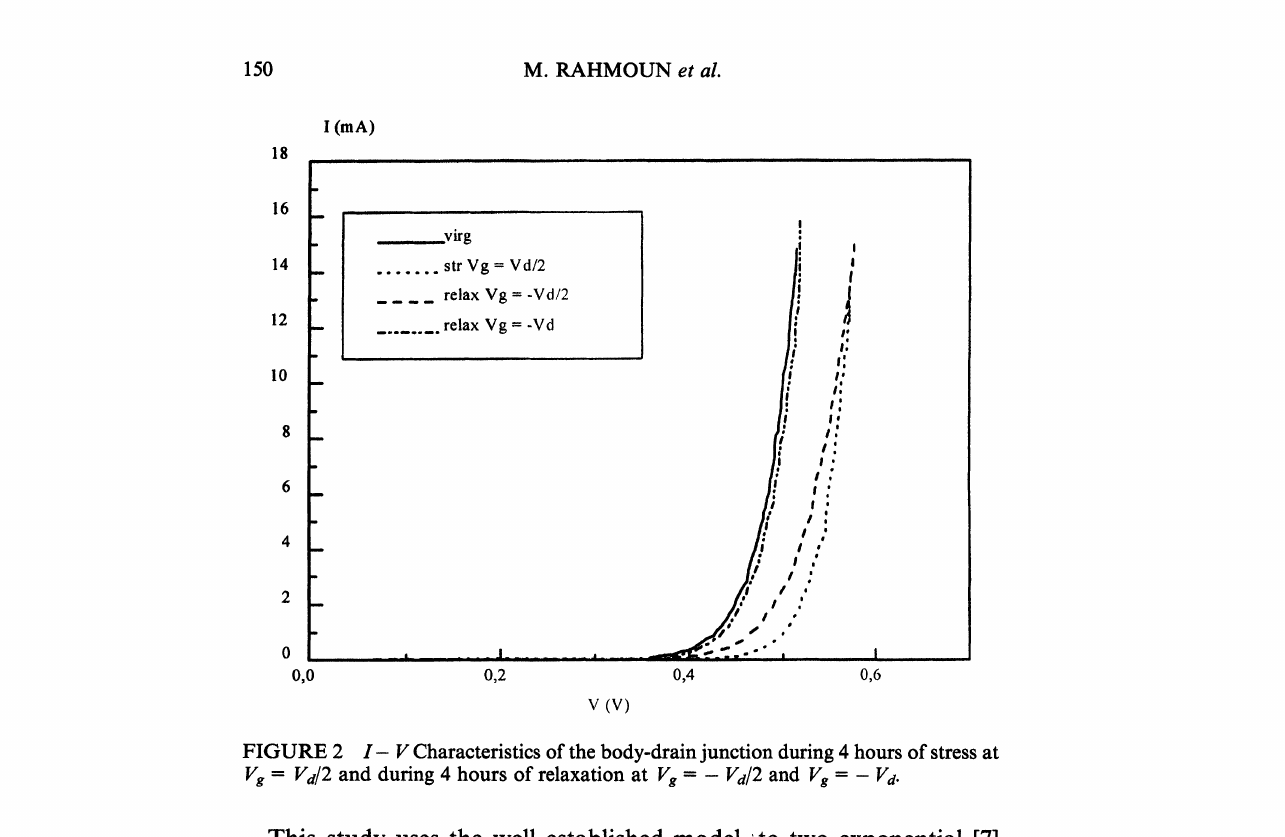
FIGURE 2 1- V Characteristics of the body-drain junction during 4 hours of stress at I/ Va/2 and during 4 hours of relaxation at F Va/2 and F